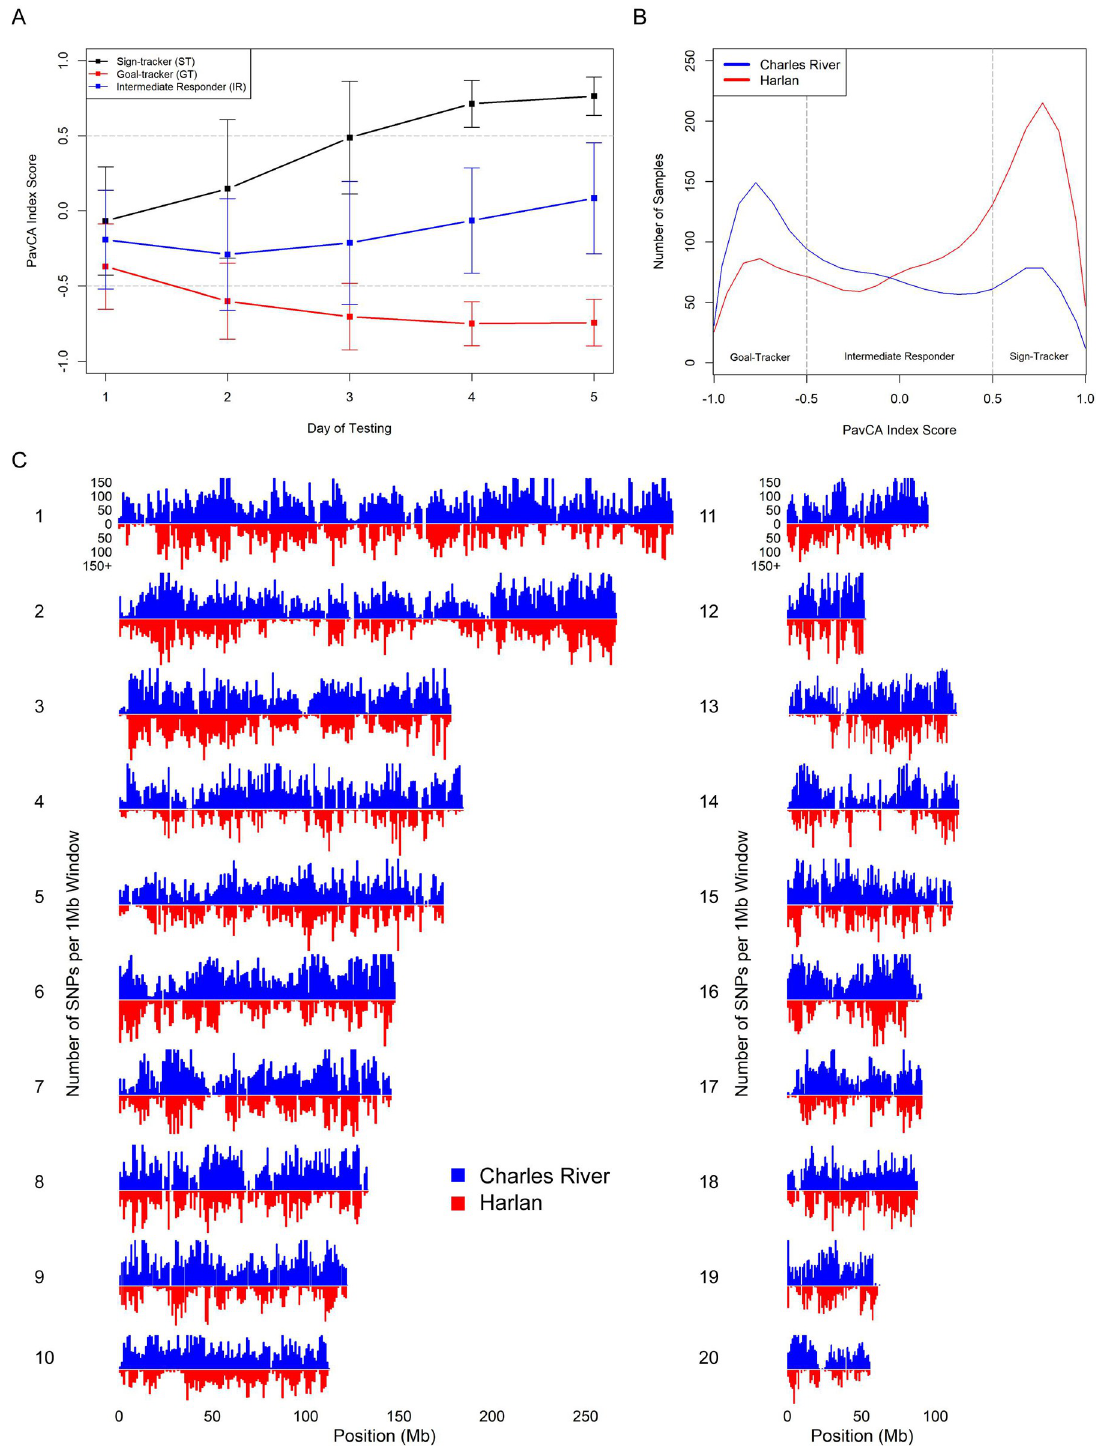
Fig 1. PavCA index score progression across days and distribution between Charles River and Harlan. (A) Samples were classified as sign-tracker, goal-tracker, or intermediate responder based on their average day 4 and 5 PavCA index score. PavCA index scores for each day of training (1–5) were averaged across all sign-trackers, goal-trackers, and intermediate responders. Bars around the points represent the standard deviation of the averages. (B) Density curves of average day 4 and 5 PavCA index score in Harlan (n = 2,281) vs. Charles River (n = 1,780) SD rats. (C) Filtered SNP density per 1Mb window in Charles River vs. Harlan samples for all 20 autosomes.